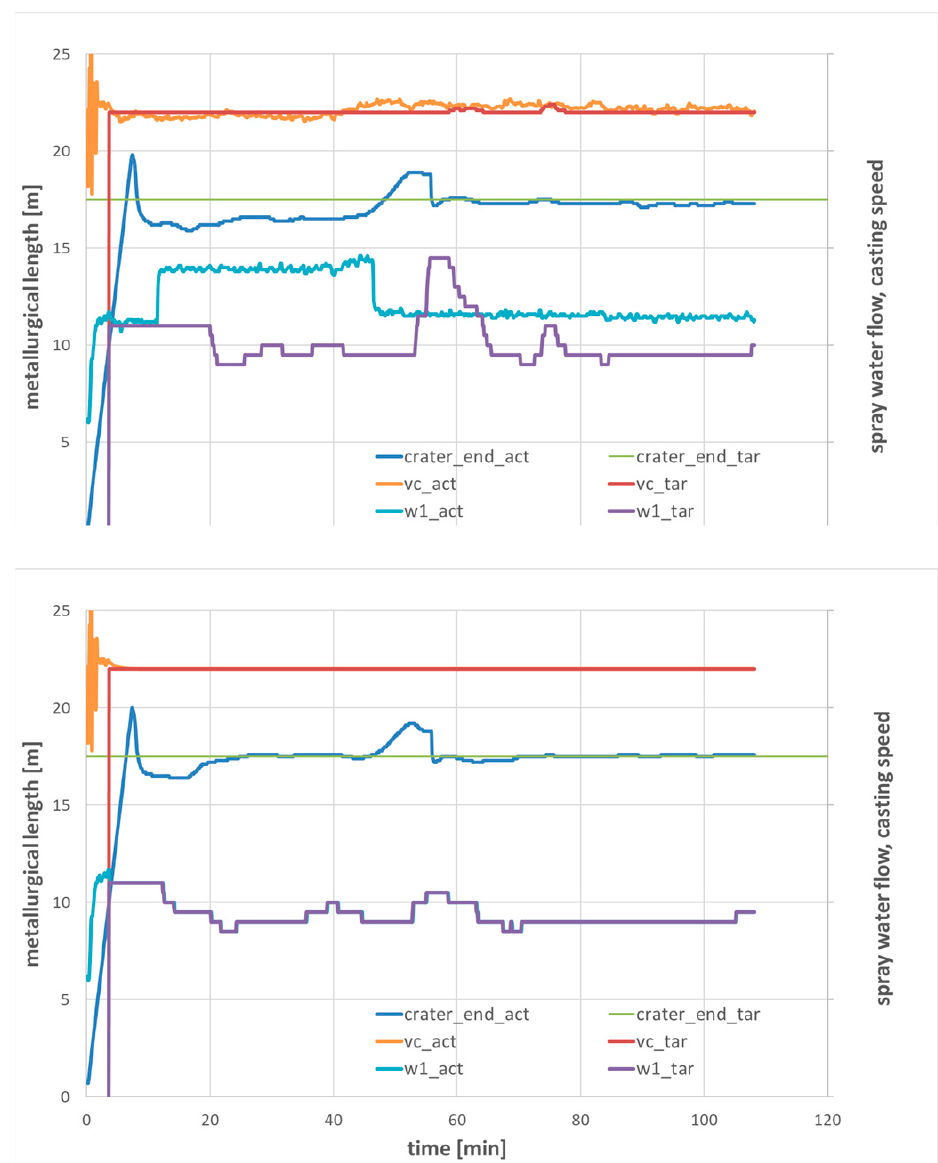
Figure 20. Evolution of actual and target casting speed, spray water flow and crater end position without ( top ) and with ( bottom ) application of target casting parameters for target crater end of 16.5 m at ESF billet caster.